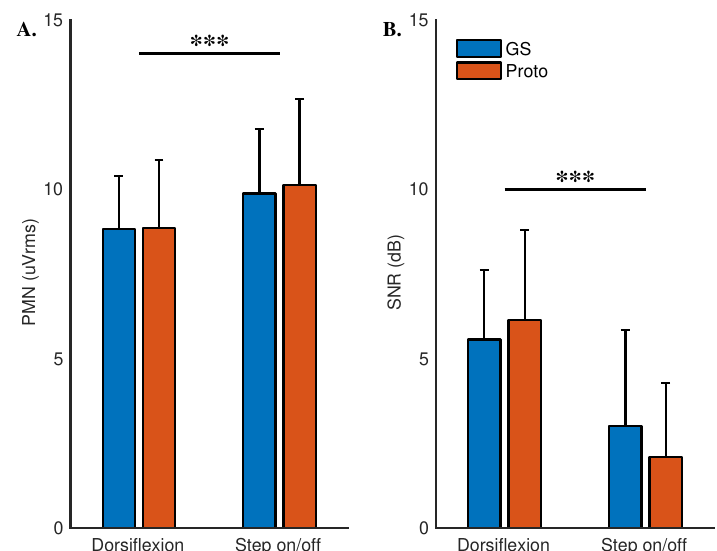
Figure 3. Means and standard deviations for ( A ) pre-movement noise and ( B ) signal-to-noise ratio. ‘***’ represents p -value less than